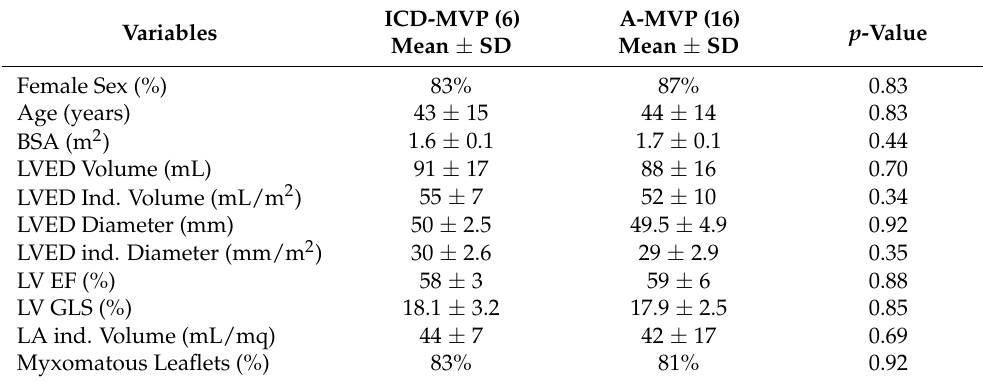
Table 1. Baseline clinical and echocardiographic variables analyzed in ICD-MVP group and A- MVP group.